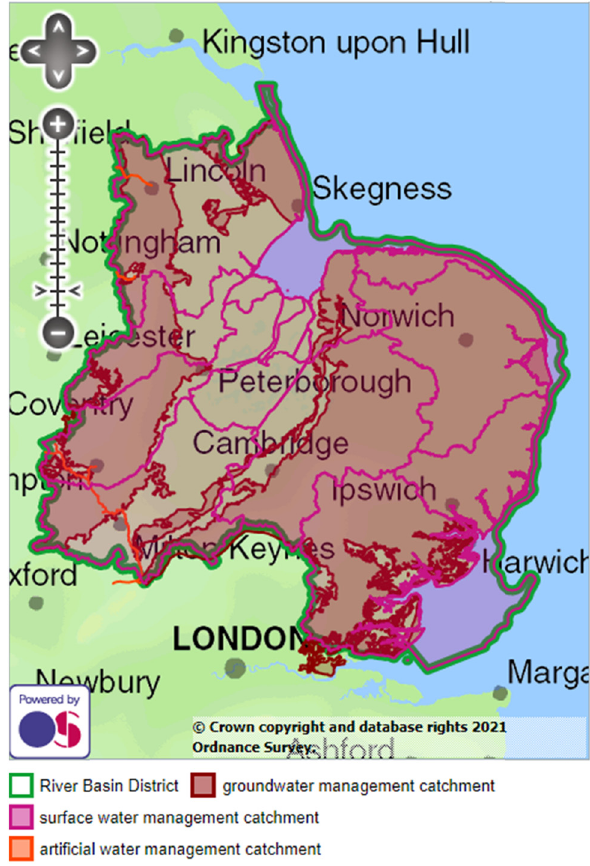
Figure 1: The RBD map [ 31 ]